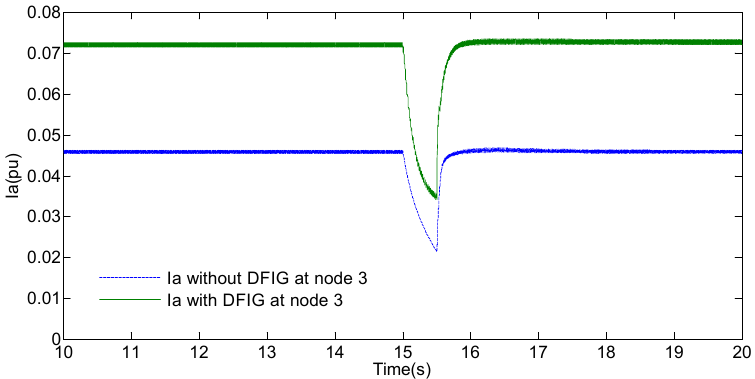
Figure 7. Phase-A currents at node 3 with and without DFIG connected, where an AG fault is applied at node 3.